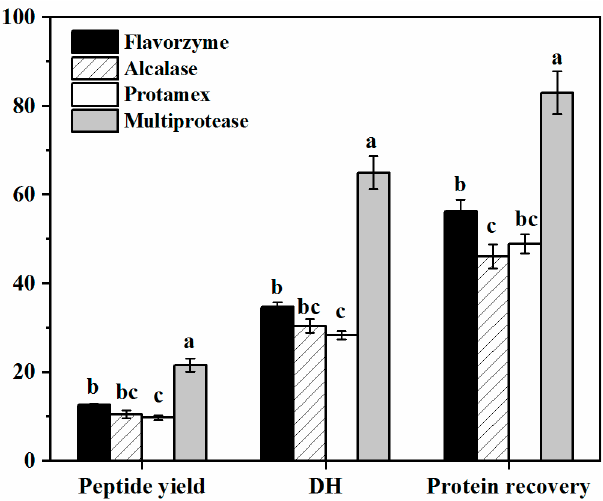
Figure 1. Taste characteristics of DPH. Different letters denote significant differences ( p < 0.05).